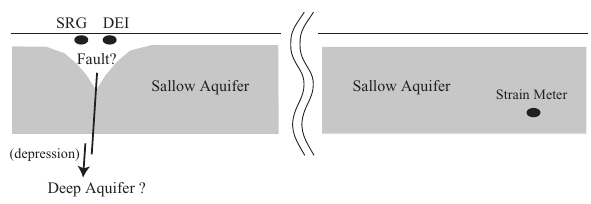
Fig. 5. Schematic diagram of a speculative mechanism of anoma- lous geoelectric field